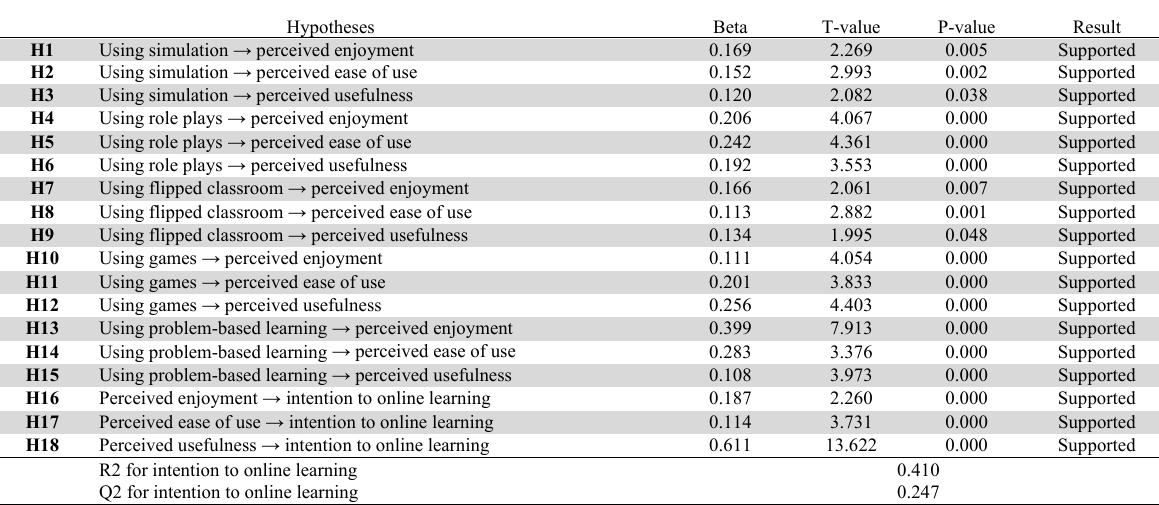
Hypotheses Testing